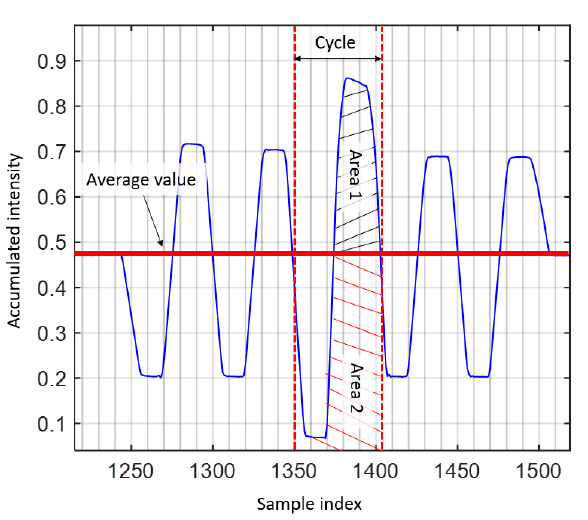
Figure 1. Defining Flicker Index [34,35]. The flicker index has a range of 0 to 1.0, with 0 representing the steady light output level. Area 2 may be close to zero provided the light output varies as periodic spikes, thus leading to a flickering index close to 1. Higher values indicate an increased possibility of noticeable flickering.